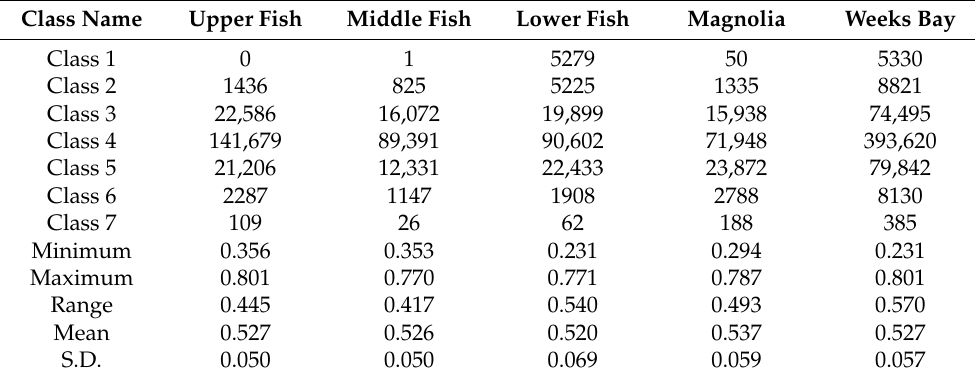
Table 2. Descriptive statistics of erosion potential in WLC